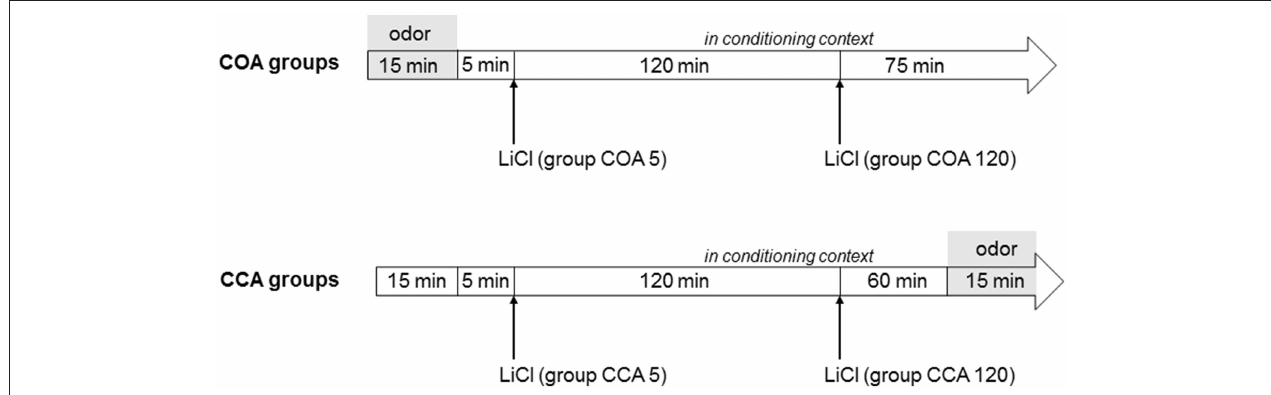
FIGURE 1 | Time schedule of the conditioning session for COA and CCA groups. In COA groups, the animals were subjected to presentation of the odor (symbolized by the gray area) in the conditioning context followed by the US with a short (5min) or a long (120min) interstimulus interval (COA 5 and COA 120 groups, respectively). The animals spent the rest of the session in the conditioning context. In CCA groups, the animals were placed in the conditioning context for 15min and thenreceivedtheUSwithashort(5min)orlong(120min)interstimulusinterval(CCA5andCCA120groups,respectively).Theanimalsspenttherestofthesessioninthe conditioning context in which the odor was presented during the last 15min of the session (symbolized by the gray area). The total duration of the session was 215min.